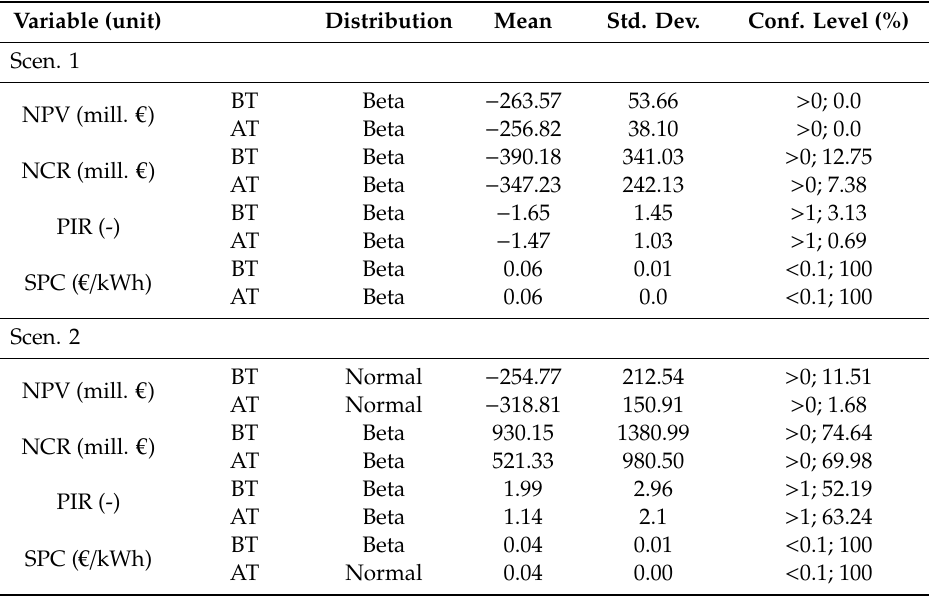
Table 14. Value-at-risk descriptives for Scen. 1 and 2, incl. flooding time. Variable